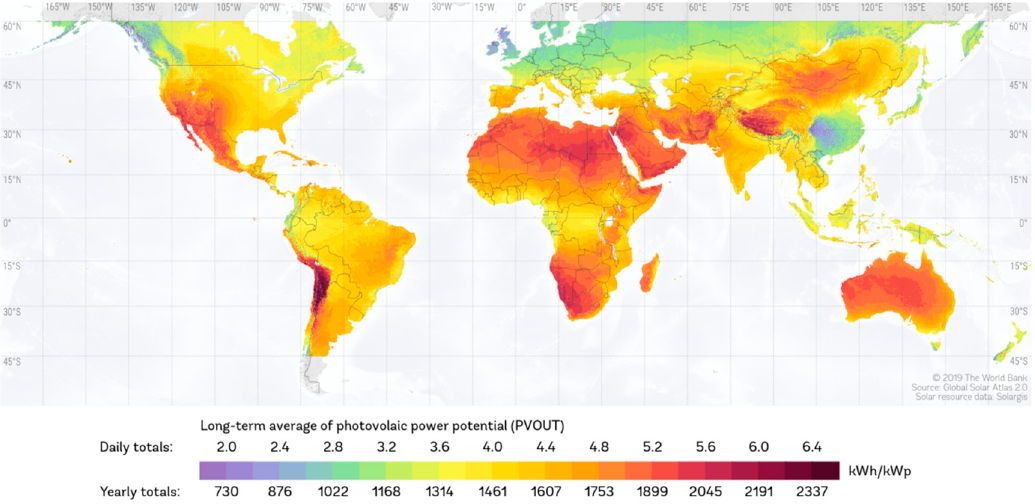
Figure 7. Photovoltaic power potential in the world. Source: [48].